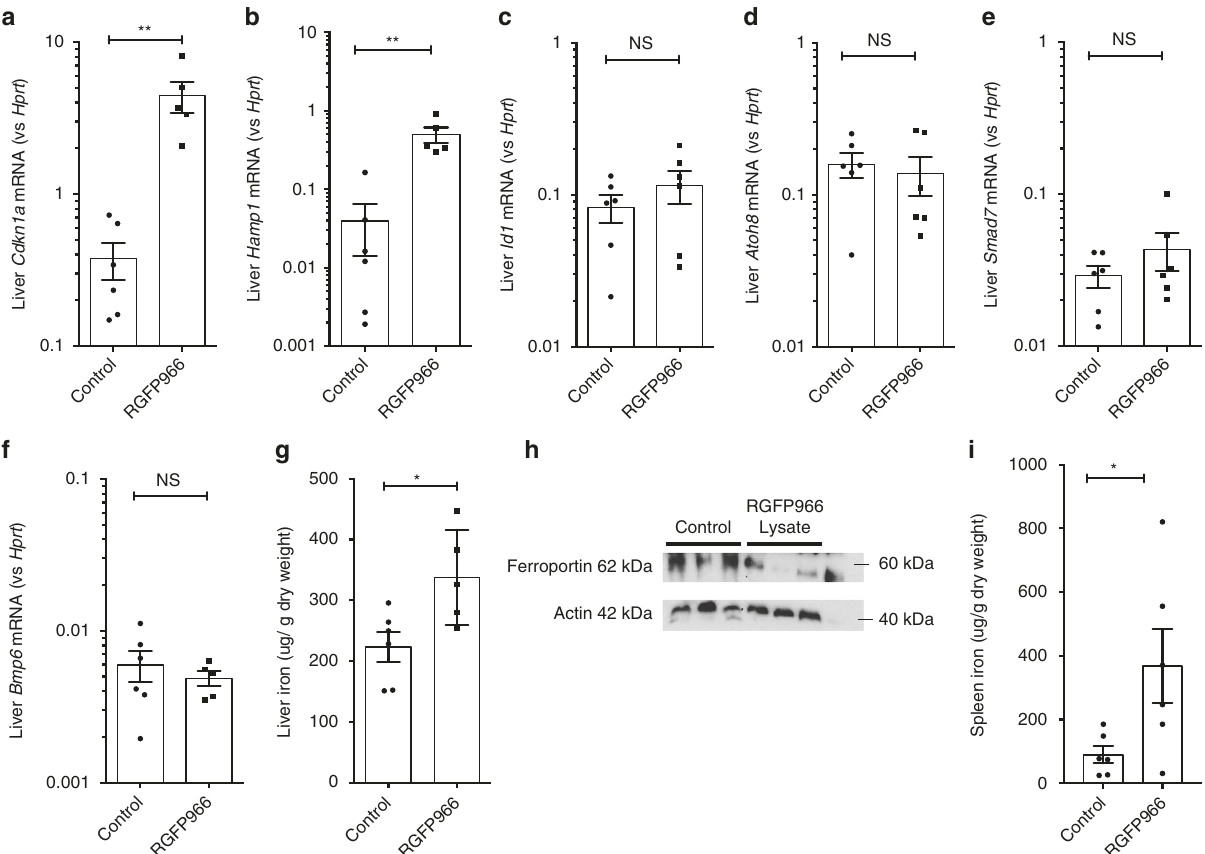
Fig. 8 Effects of HDAC3 inhibition in vivo on hepcidin expression in iron-de fi cient mice. Four-week-old C57Bl/6 mice were fed a low-iron diet (2 ppm) for 3 weeks, followed by two doses of RGFP966 2 h apart, and killed 2 h following the second dose. Effect on hepatic a Cdkn1a , b Hamp1 , c Id1 , d Atoh8 , e Smad7 , and f Bmp6 mRNA expression, g liver iron. h Western blot for hepatic ferroportin expression. i Effect of RGFP966 on spleen iron. N = 6 per group. Data